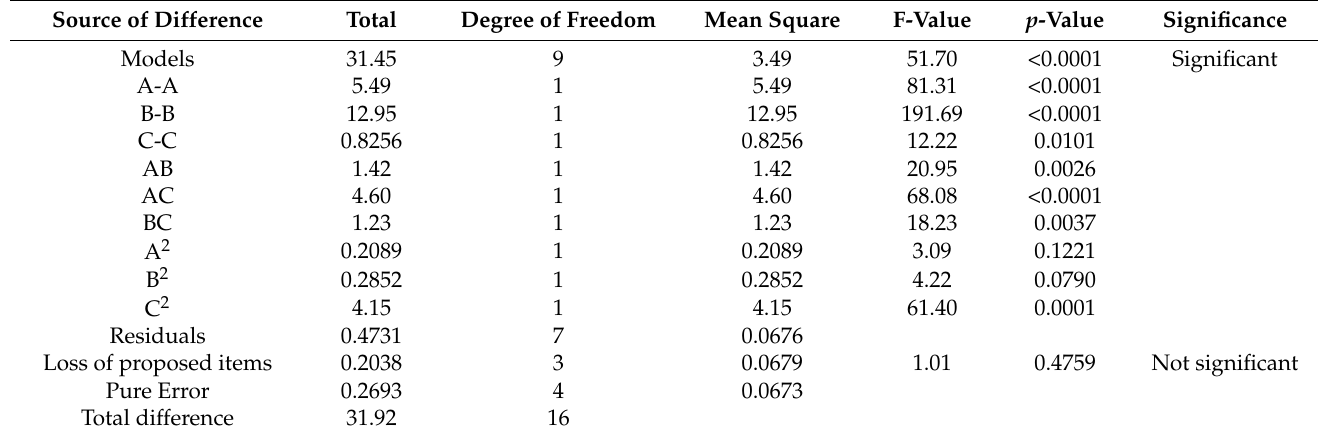
Table 10. Box–Behnken response surface variance analysis results of pan-fried green